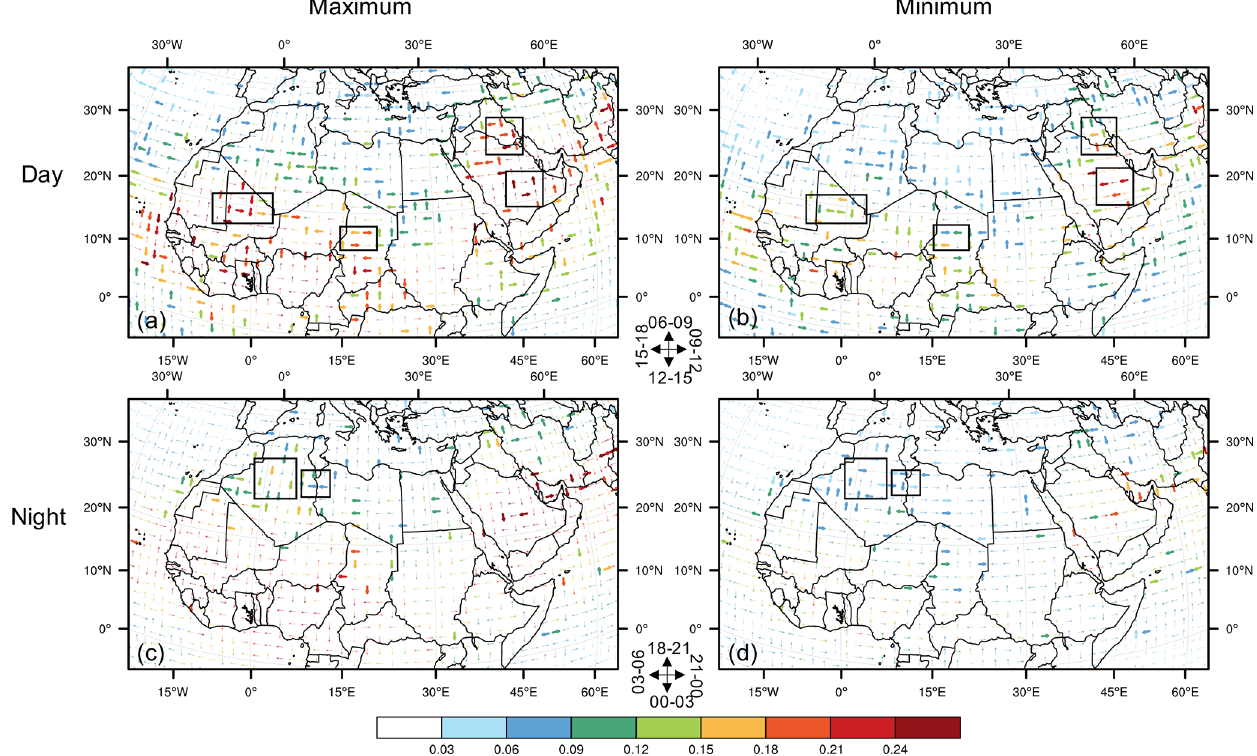
Figure 4. Diurnal (a, c) maximum and (b, d) minimum DAOD across North Africa and the Middle East during (a, b) daytime and (c, d) nighttime periods. Direction of the vectors indicates the local time when mean DAOD reaches the (a, c) maximum and (b, d) minimum value during the (a, b) day and (c, d) night. Color of the vectors indicates the (a) maximum and (b) minimum DAOD value. Thick vectors indicate statistically significant diurnal variability ( p< 0 . 05) according to the ANOVA-based F test. In panels (a) and (b) , the boxes show the location of the West African El Djouf, Bodélé Depression, Iraqi desert, and Rub’ al-Khali desert from west to east. In panels (c) and (d) , the boxes indicate the Grand Erg Occidental and Grand Erg Oriental from west to